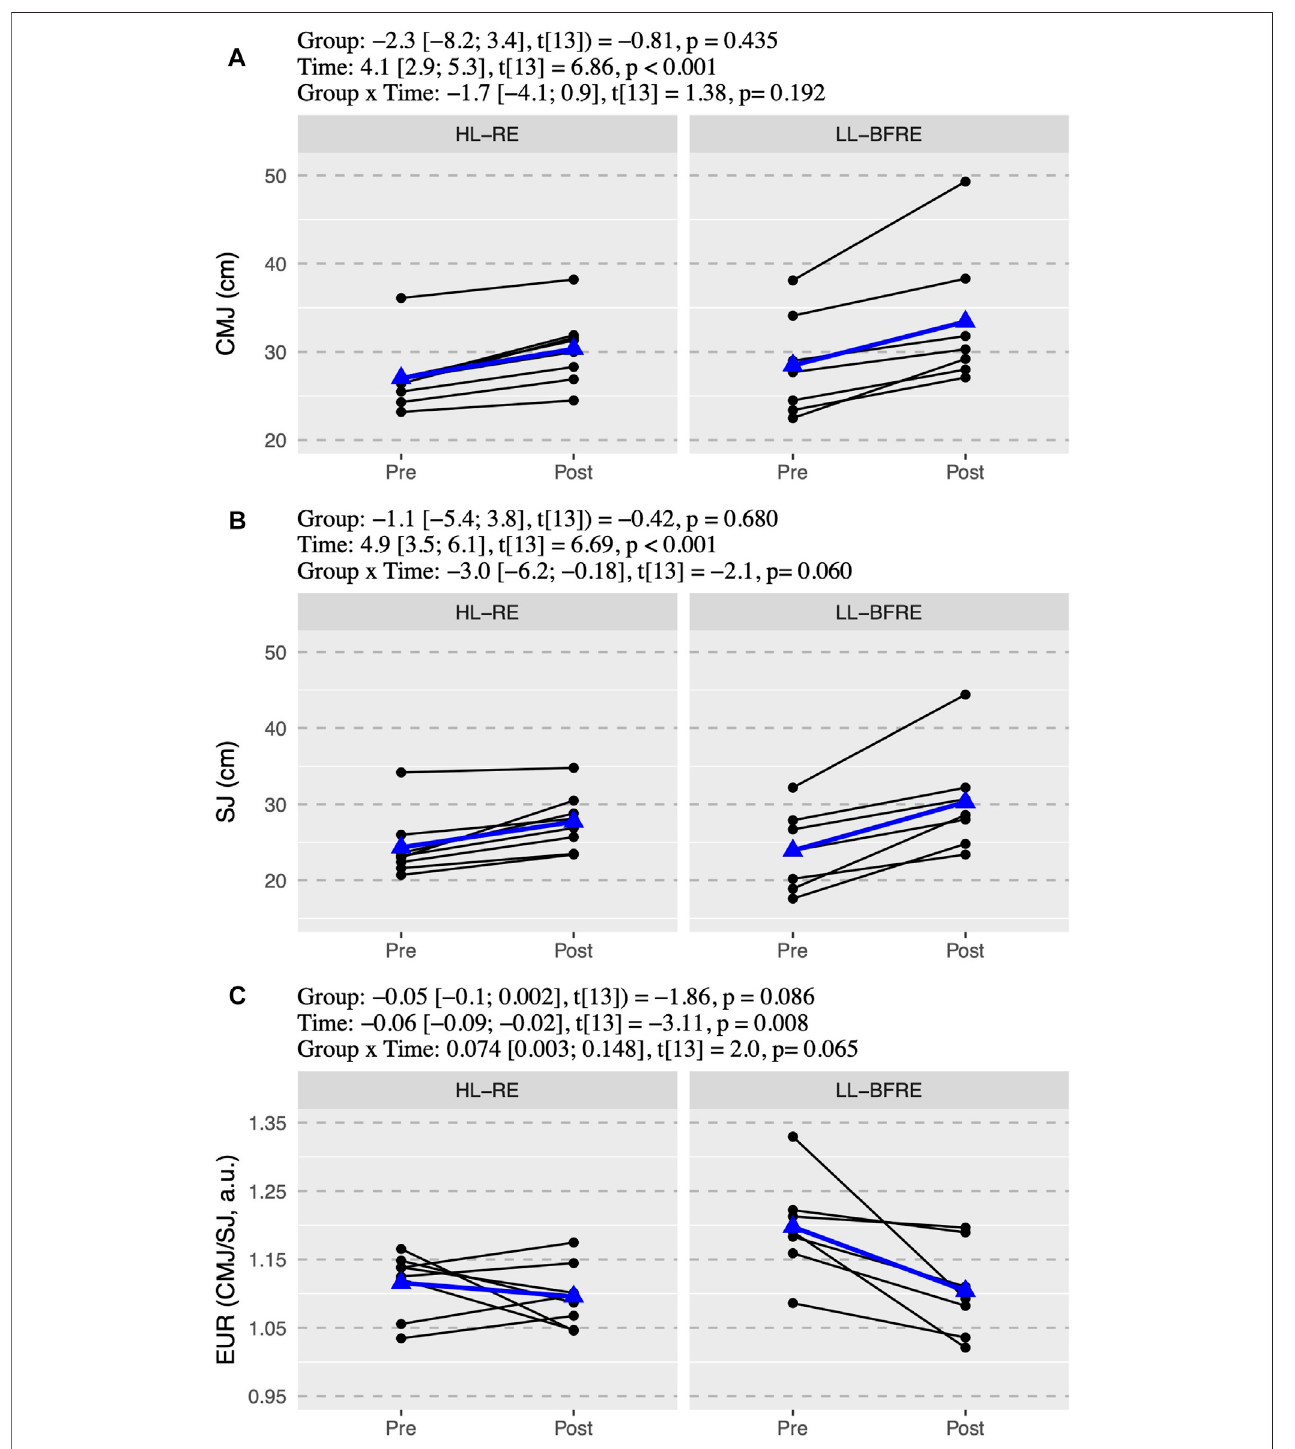
FIGURE1| Thecountermovementjump (A) ,thesquatjumptest (B) ,andtheeccentricutilizationratio(EUR=CMJ/SJ) (C) values.Blackpointsandlinesrepresent individual responses. Blue triangles and regression line represent the mean response. Effects of the group (HL-RE vs. LL-BFRE), time (POST vs. PRE) and interaction (HL-REvs.LLBFRE*POSTvs.PRE)arepresentedthroughbetacoef fi cientand95%ofthecon fi denceinterval,t-valueand p -valueobtainedaftermixedmodelanalysis. HL-RE: high-load exercises group; LL-BFRE: low-load blood fl ow restriction exercise group; CMJ: countermovement jump, SJ: squat jump test, EUR: eccentric utilization